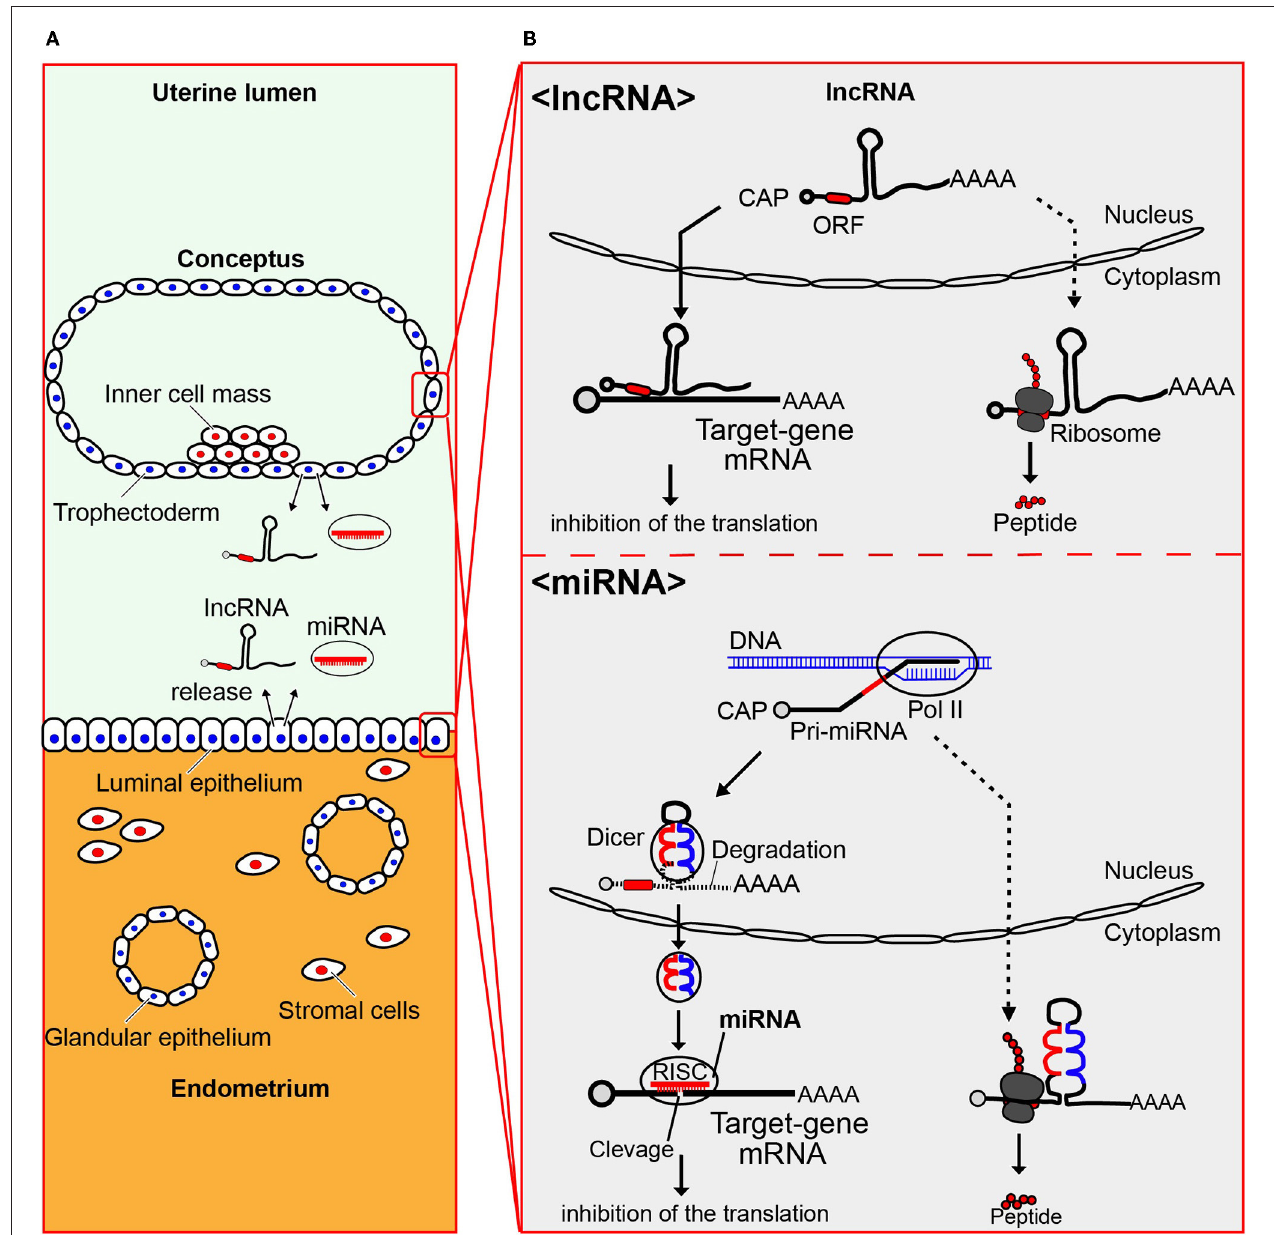
FIGURE 1 | miRNA and lncRNA, produced by both conceptus and endometrium, are present in the uterus. (A) Uterine structure showing both maternal endometrium and conceptus (embryo plus extraembryonic membranes), from which miRNA and lncRNA are produced and miRNA in EVs and lncRNA are released into the uterine lumen. (B) Processing of lncRNA and miRNA is shown. Long non-coding RNAs (lncRNAs) are those with a length exceeding 200 nucleotides, some of which translate proteins/polypeptides (dotted-line arrow). lncRNA can regulate the expression of target genes at the post-transcriptional level through the inhibition of their translation (solid-line arrow). Primary transcripts of miRNAs can be several kilobases in length, which are successfully cleaved by two RNase III enzymes, Drosha and Dicer, to produce approximately 70 nucleotide long precursor miRNA, and finally become 22–24 nucleotide long mature miRNAs (51) (solid-line arrow). The dotted-line arrow indicates that a part of those possibly produce polypeptides. When delivered into target cells, the miRNAs are likely to inhibit target mRNAs post-transcriptionally through the formation of RNA induced silencing complex (RISC), leading to changes in gene expression and cellular functions in distant cells.